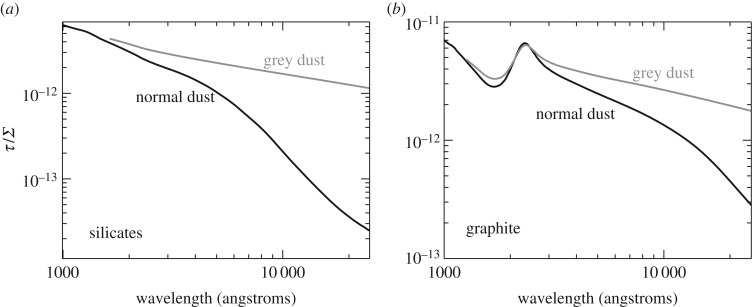
(a) Extinction curves for a population of silicate dust grains with a normal particle size distribution (black) with grain diameter in the range of a=0.005–0.25 μm, and a grey distribution (or distribution skewed to large dust grains), with diameter in the range of a=0.005–10.0 μm. The particle size distribution is of the form (a/a0)−3.5 [263]. (b) Same as left figure, but for a population of graphite dust grains. In both panels, the y-axis is the optical depth, τ, divided by the column density of dust, Σ (Credit: Adria Updike, NASA/GSFC).